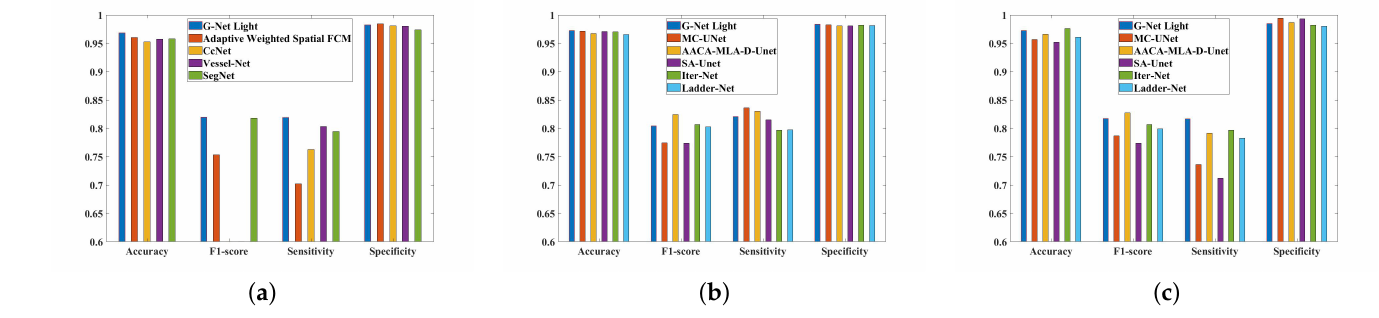
Figure 6. Quality measurements for datasets: ( a ) DRIVE; ( b ) CHASE; ( c )